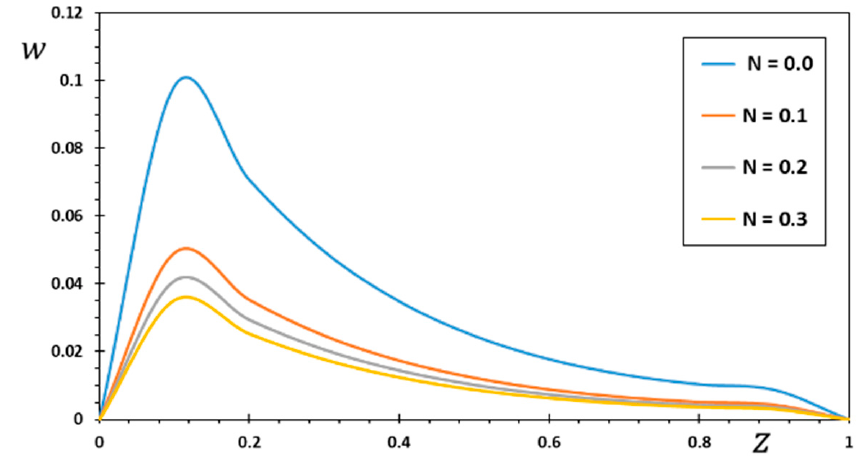
Figure 2. Variation of displacement w for various values of the gradient coefficient N .